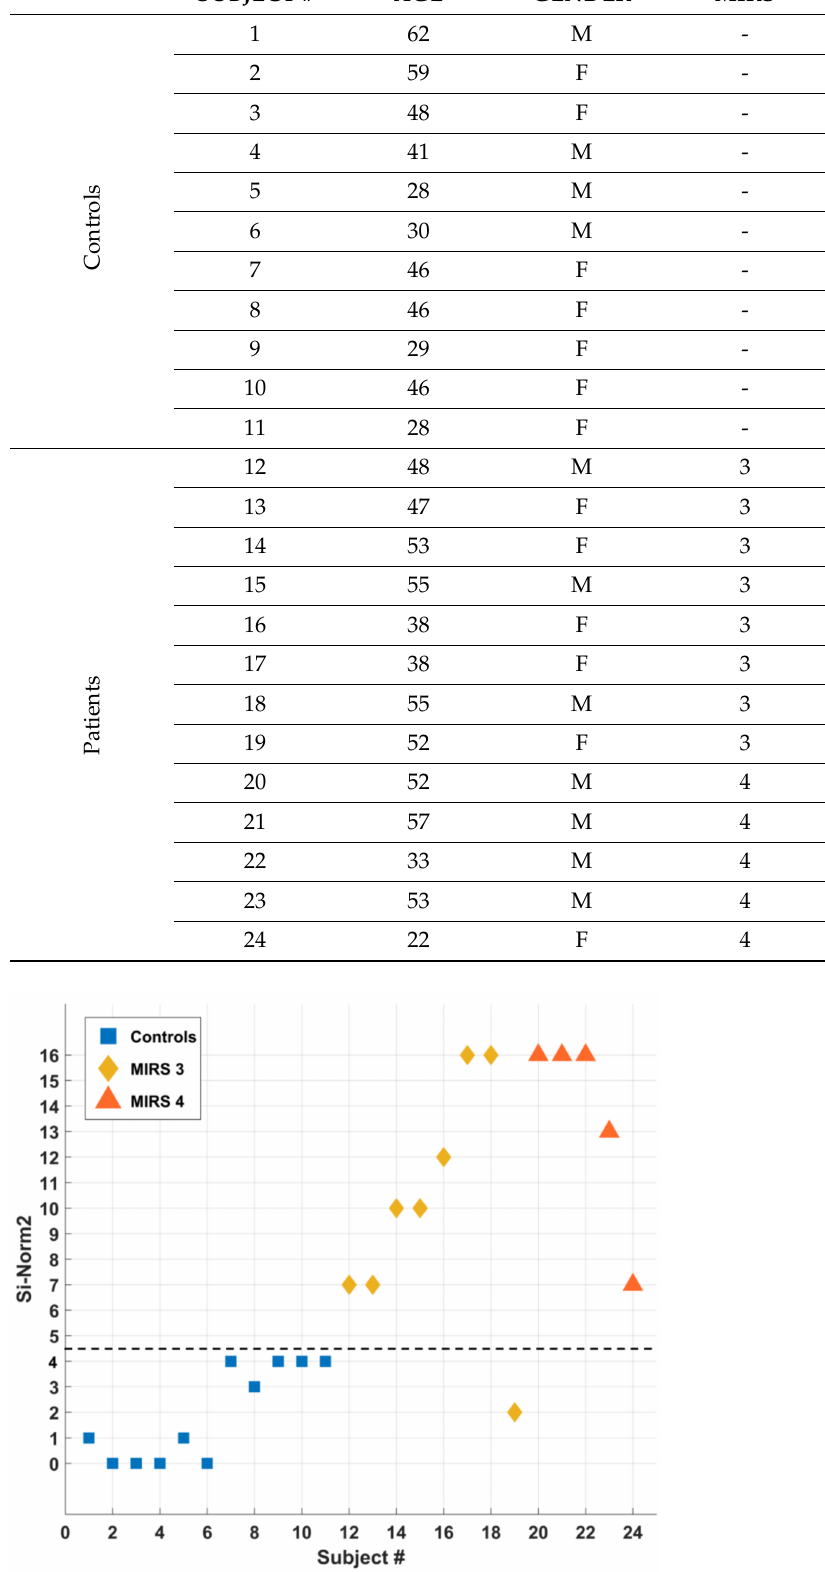
Figure 7. SI-Norm2 classification of all tested subjects. The dashed black line SI-Norm2 = 4 separates the controls (squares) from the patients (diamonds and